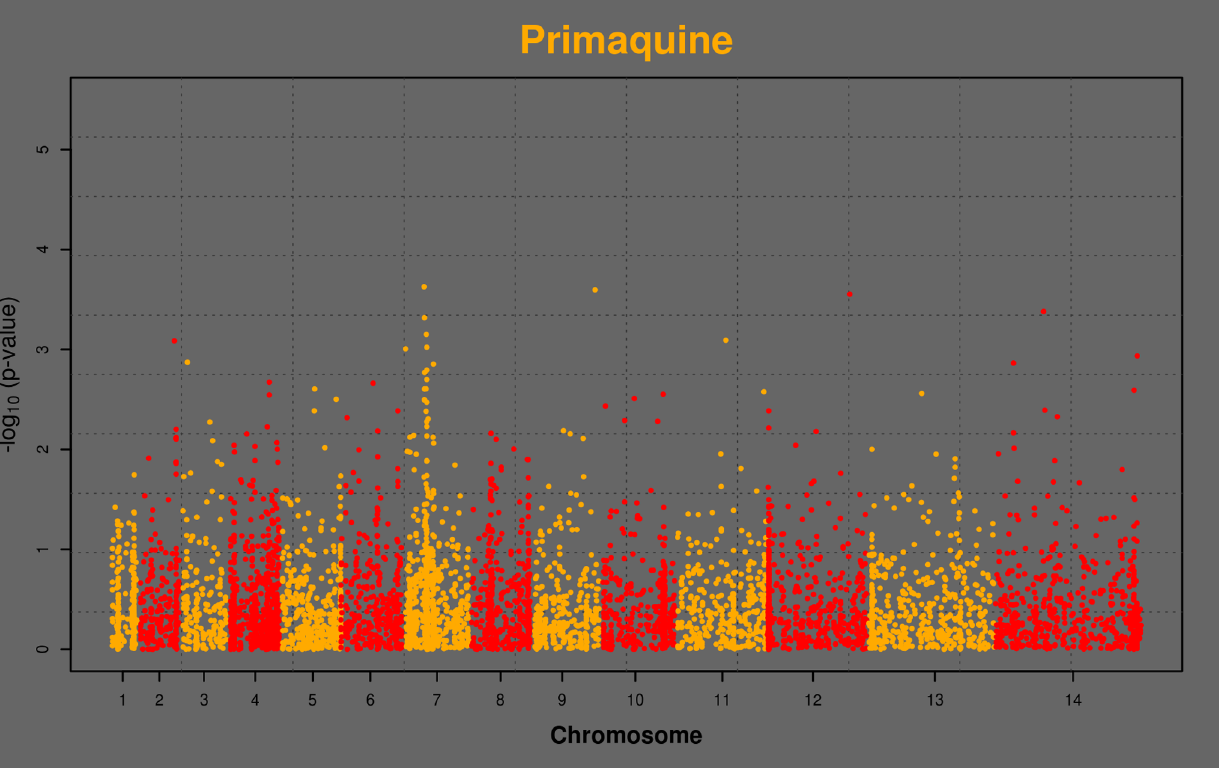
Figure 2. Manhattan plot of genome-wide associations with PQ activities from 35 parasite isolates. Horizontal axis is genome position, and vertical axis is –log 10 (p-value). Chromosomes alternate yellow and red, starting from chromosome 1 on the left. Yellow spire on chromosome 7 is in the region of pfcrt .